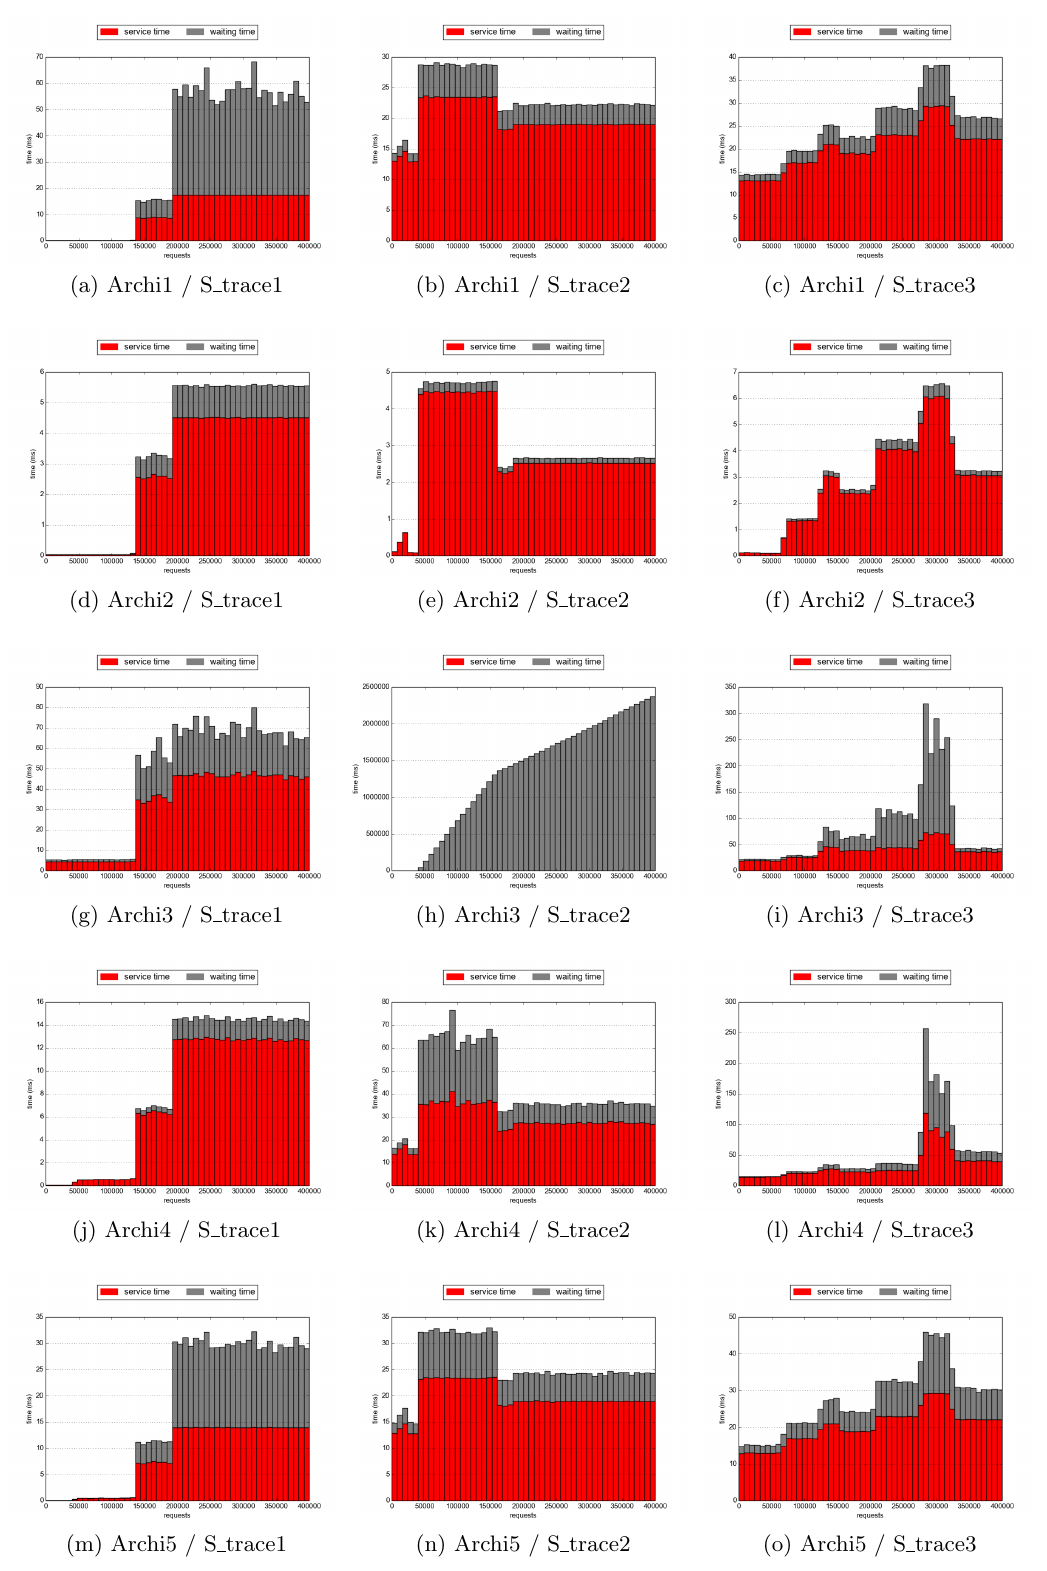
Figure 6: Experiment